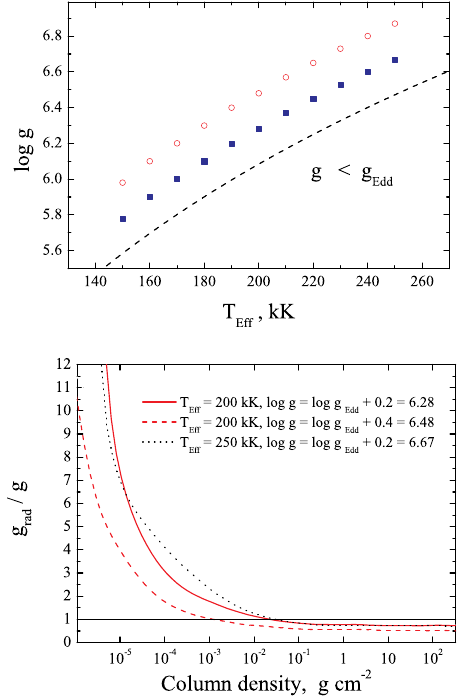
Figure 1: Top panel: Positions of the computed model atmospheres in the T eff –log g plane. The dashed curve demarcates the Eddington limit (log g = log g Edd ). Bot- tom panel: The relative radiation force vs. depth for various model atmospheres.